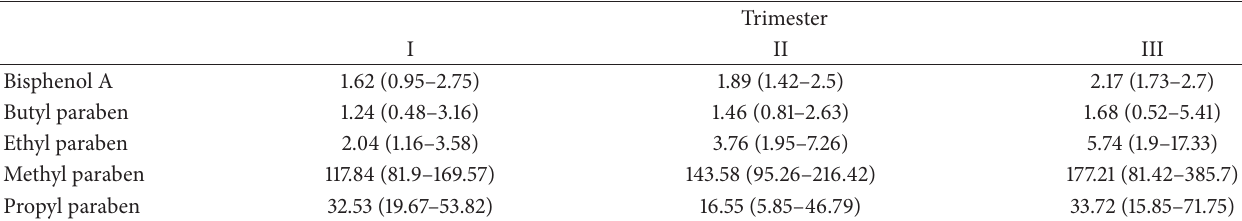
Table 3: Unadjusted geometric means with 95% confidence intervals in ng/mg creatinine for selected endocrine disrupting chemicals by pregnancy trimester. Data from the National Health and Nutrition Examination Survey